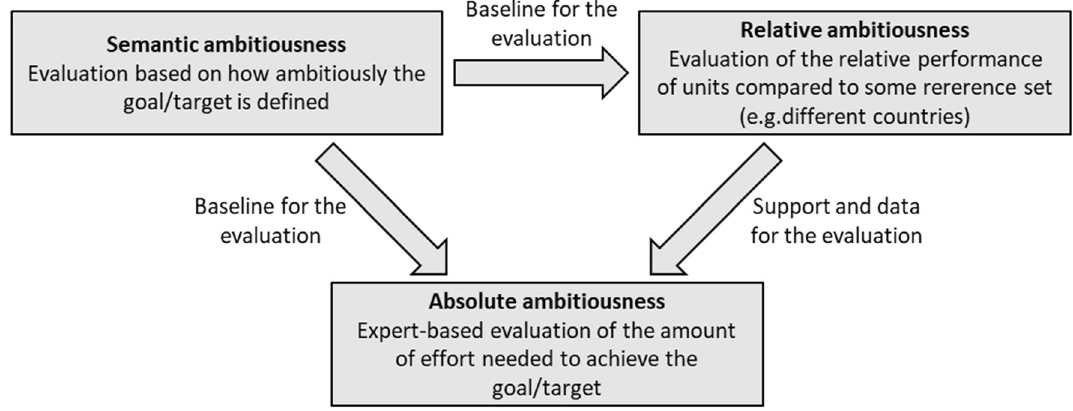
Fig. 1 Relationships between evaluating different types of ambitiousness as defined in this